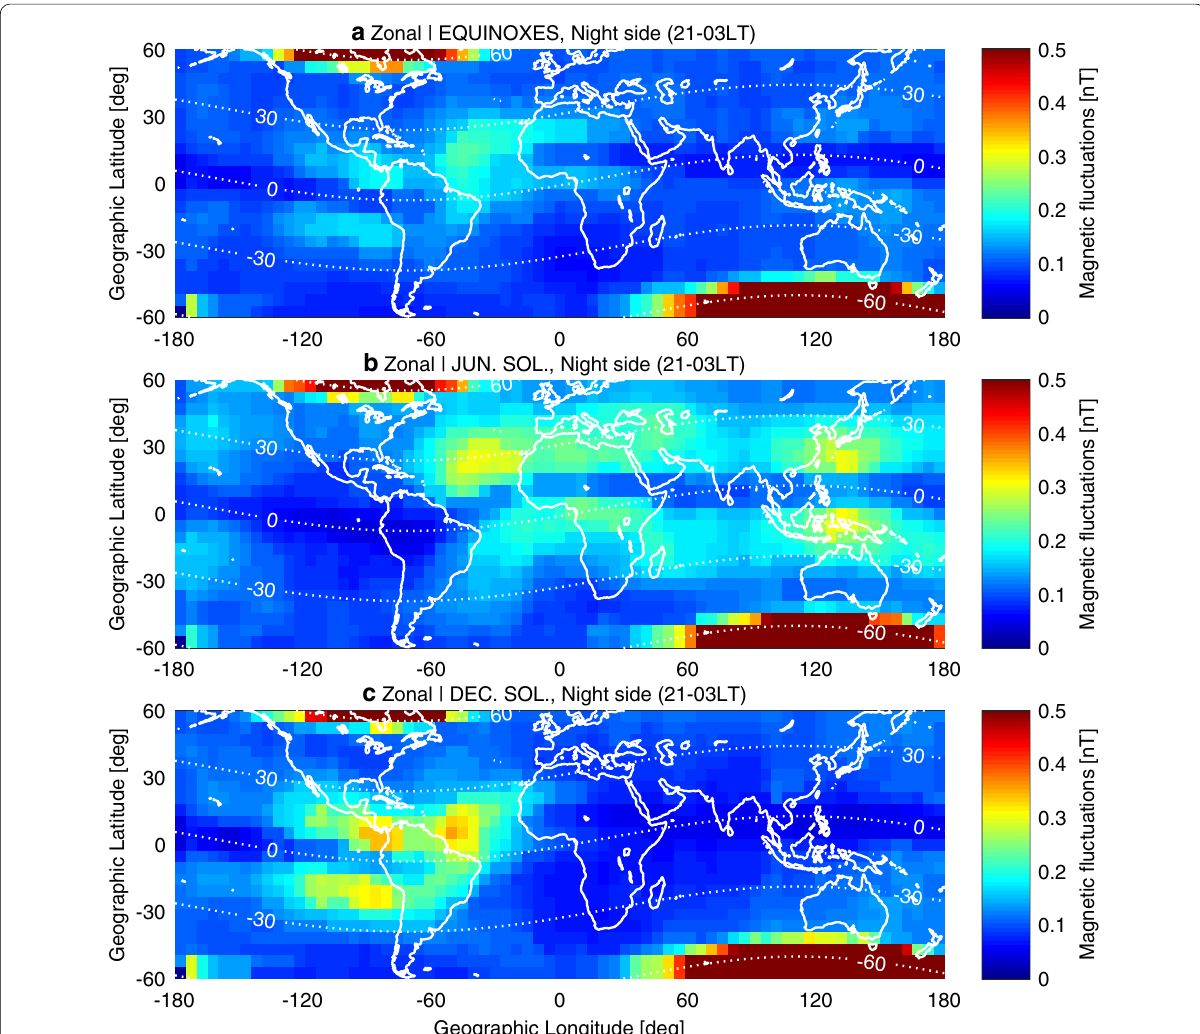
Fig. 4 Seasonal dependence of the MR amplitude distribution of the zonal component on the night side sector (21–3 LT). a Combined equinox, b June solstice and c December